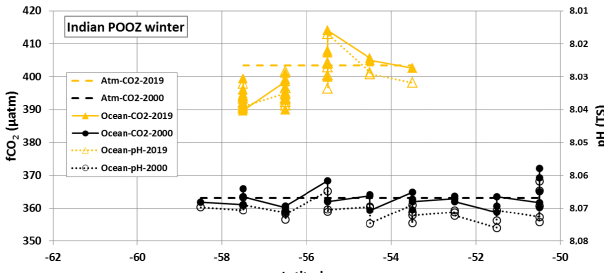
Figure A1. Monthly (gridded 1 × 1) fCO 2 and pH in the POOZ in austral winter 2000 (OISO-5, in black) and 2019 (USV, in yel- low). Dotted lines represent the atmospheric fCO 2 in 2000 and 2019. The mean difference in fCO 2 is + 35.8µatm in 19 years, i.e. + 1.9µatmyr − 1 . The mean difference in pH is − 0.0368 in 19 years, i.e. − 0.0019yr − 1 . Note that pH scale is reversed for easier